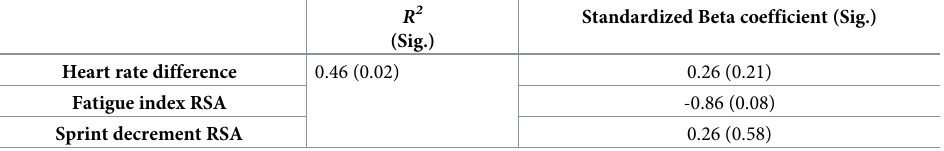
Table 4. Fatigue predictors for kicking velocity. Linear Regression.